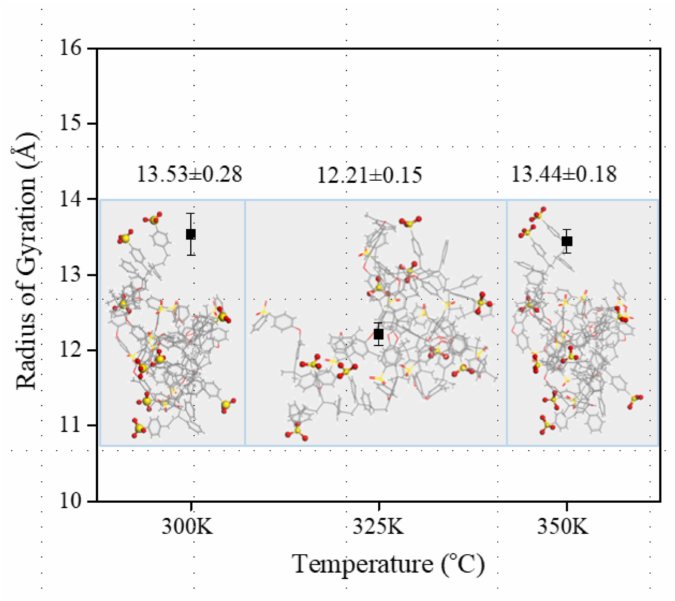
Figure 10. The radius of gyration of the SPAES-6 polymers at different